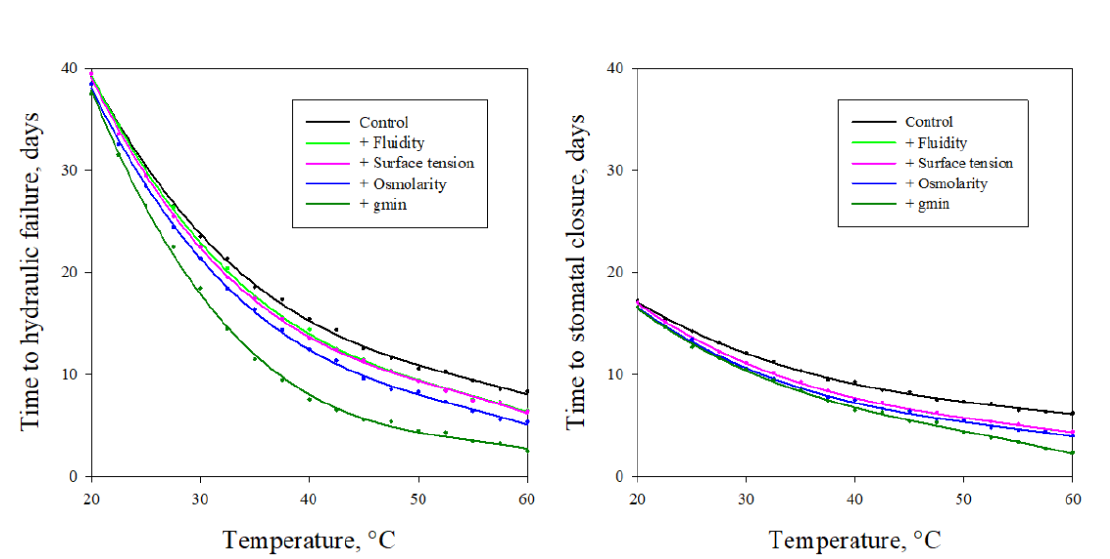
Figure 4. Impact of different processes thermodynamically determined by temperature on the timing of hydraulic failure (tHF) and stomatal closure (right). The black line represents the temperature response of tHF for a plant where only the VPD effect was modelled. The color lines show the additive effects of water fluidity (light green), water surface tension (pink), osmolarity (blue) and cuticular conductance (dark